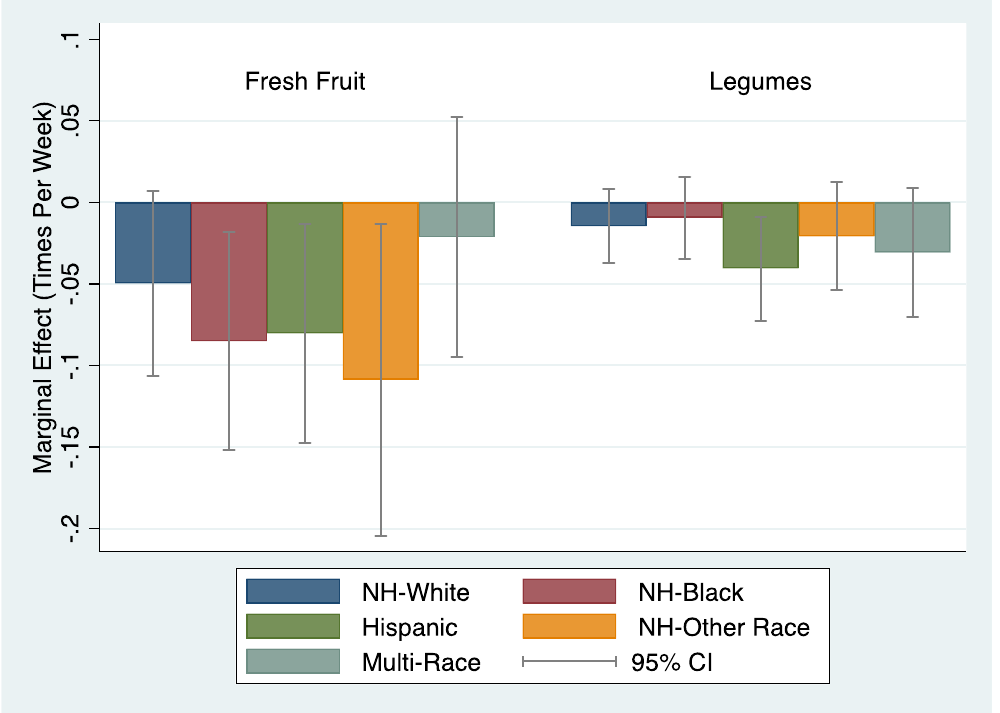
Figure 2. Differences in the association of housing price and food consumption by race/ethnicity.